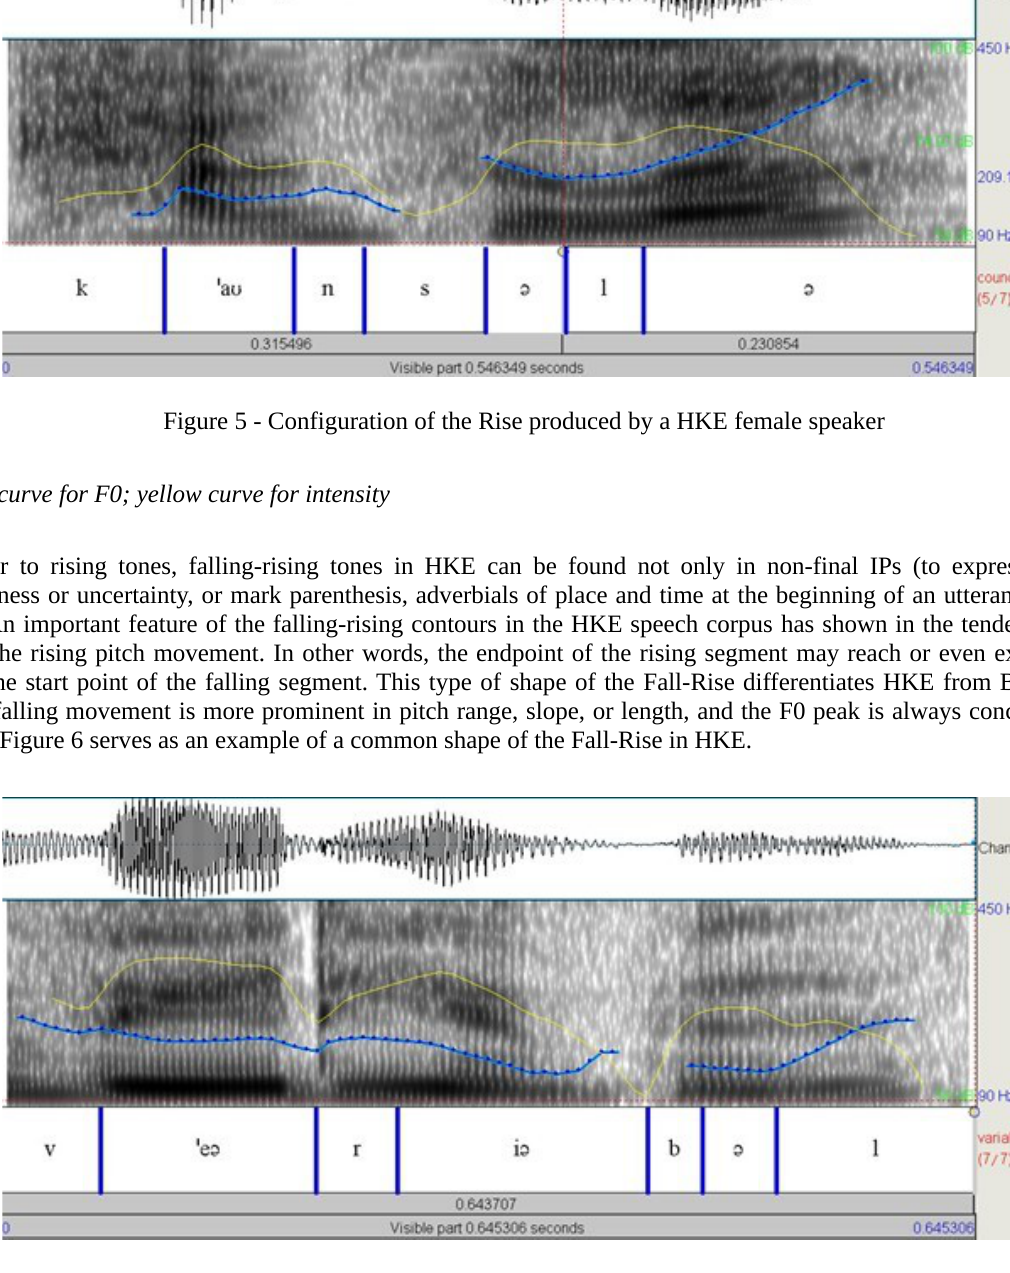
Figure 6 - Configuration of the Fall-Rise produced by a HKE female